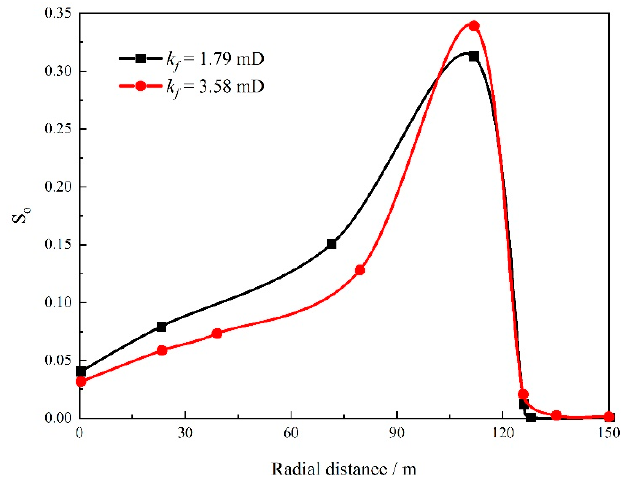
Figure 11. Radial condensate oil saturation under different fracture permeability.